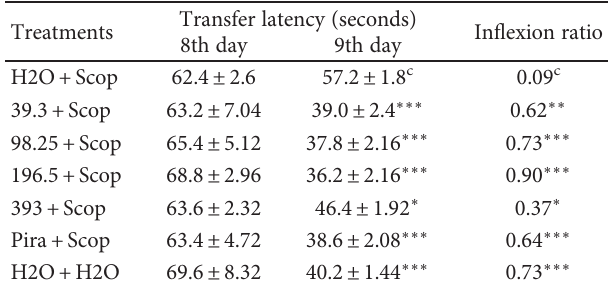
Table 2: E ff ect of M. inermis in scopolamine-induced cognitive de fi cit mice in